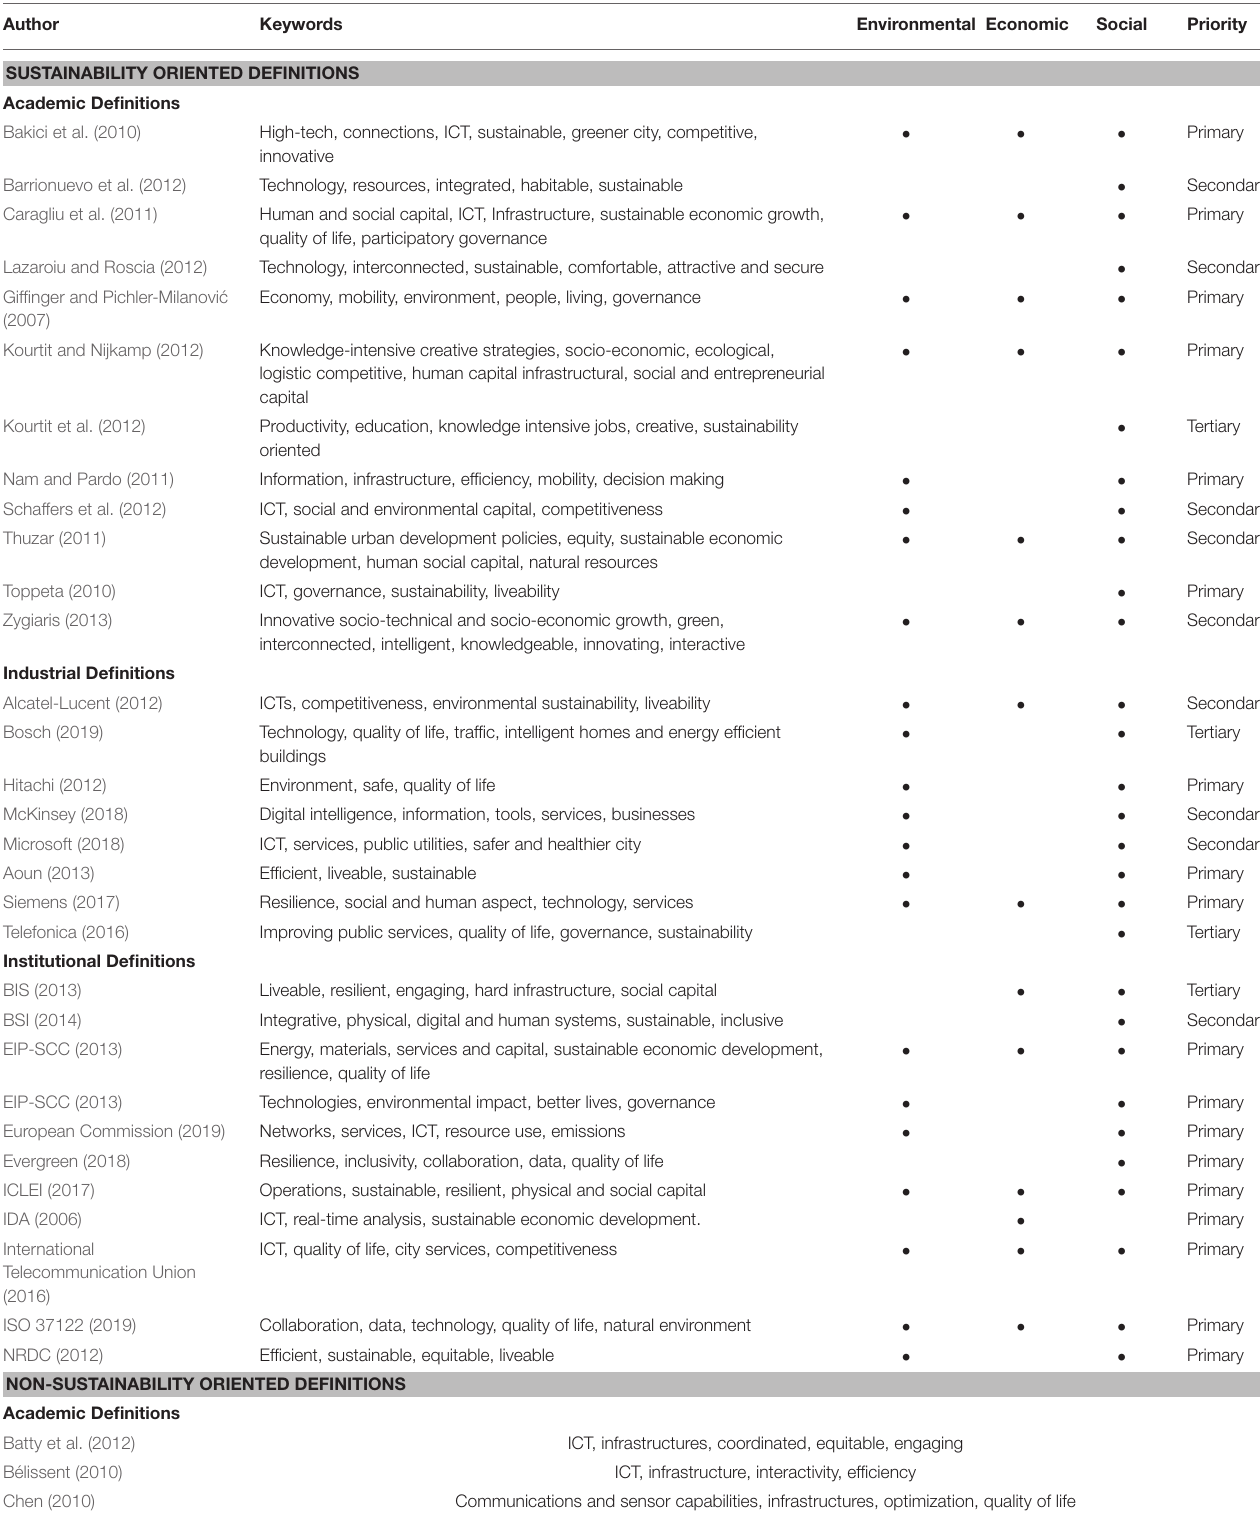
TABLE 1 | The definitions retrieved by the literature and cataloged according to whether they are sustainability oriented and if yes, which dimension (environmental, economic, or social) is present in the definition and how high of a priority it appears to